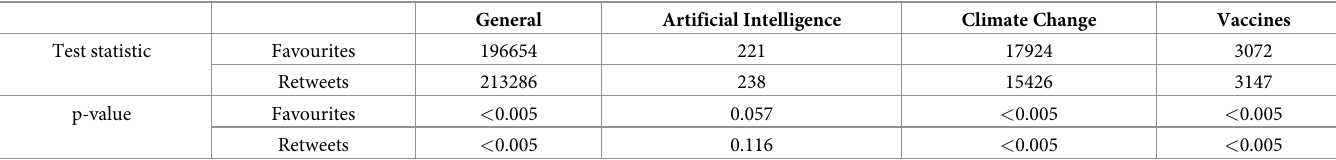
Table 4. (Twitter) test statistics and p-values for the Mann-Whitney U test used for comparing the distributions of posts following and not following the